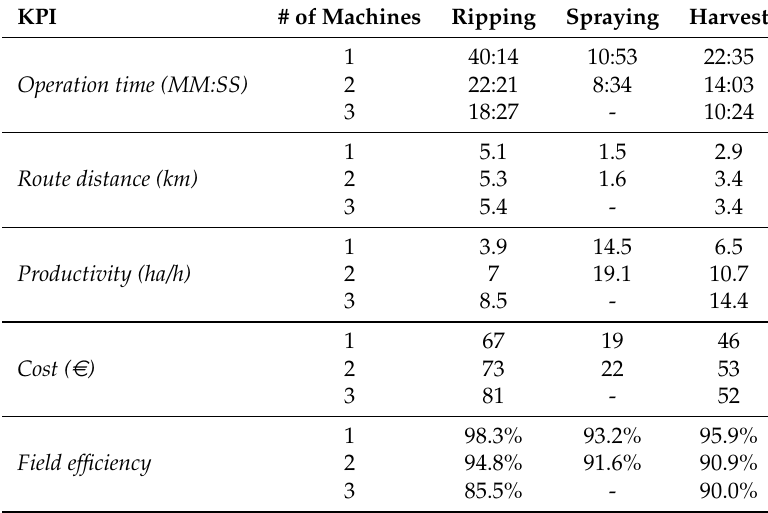
Table 4. Key performance indicators for 1 vs. 2